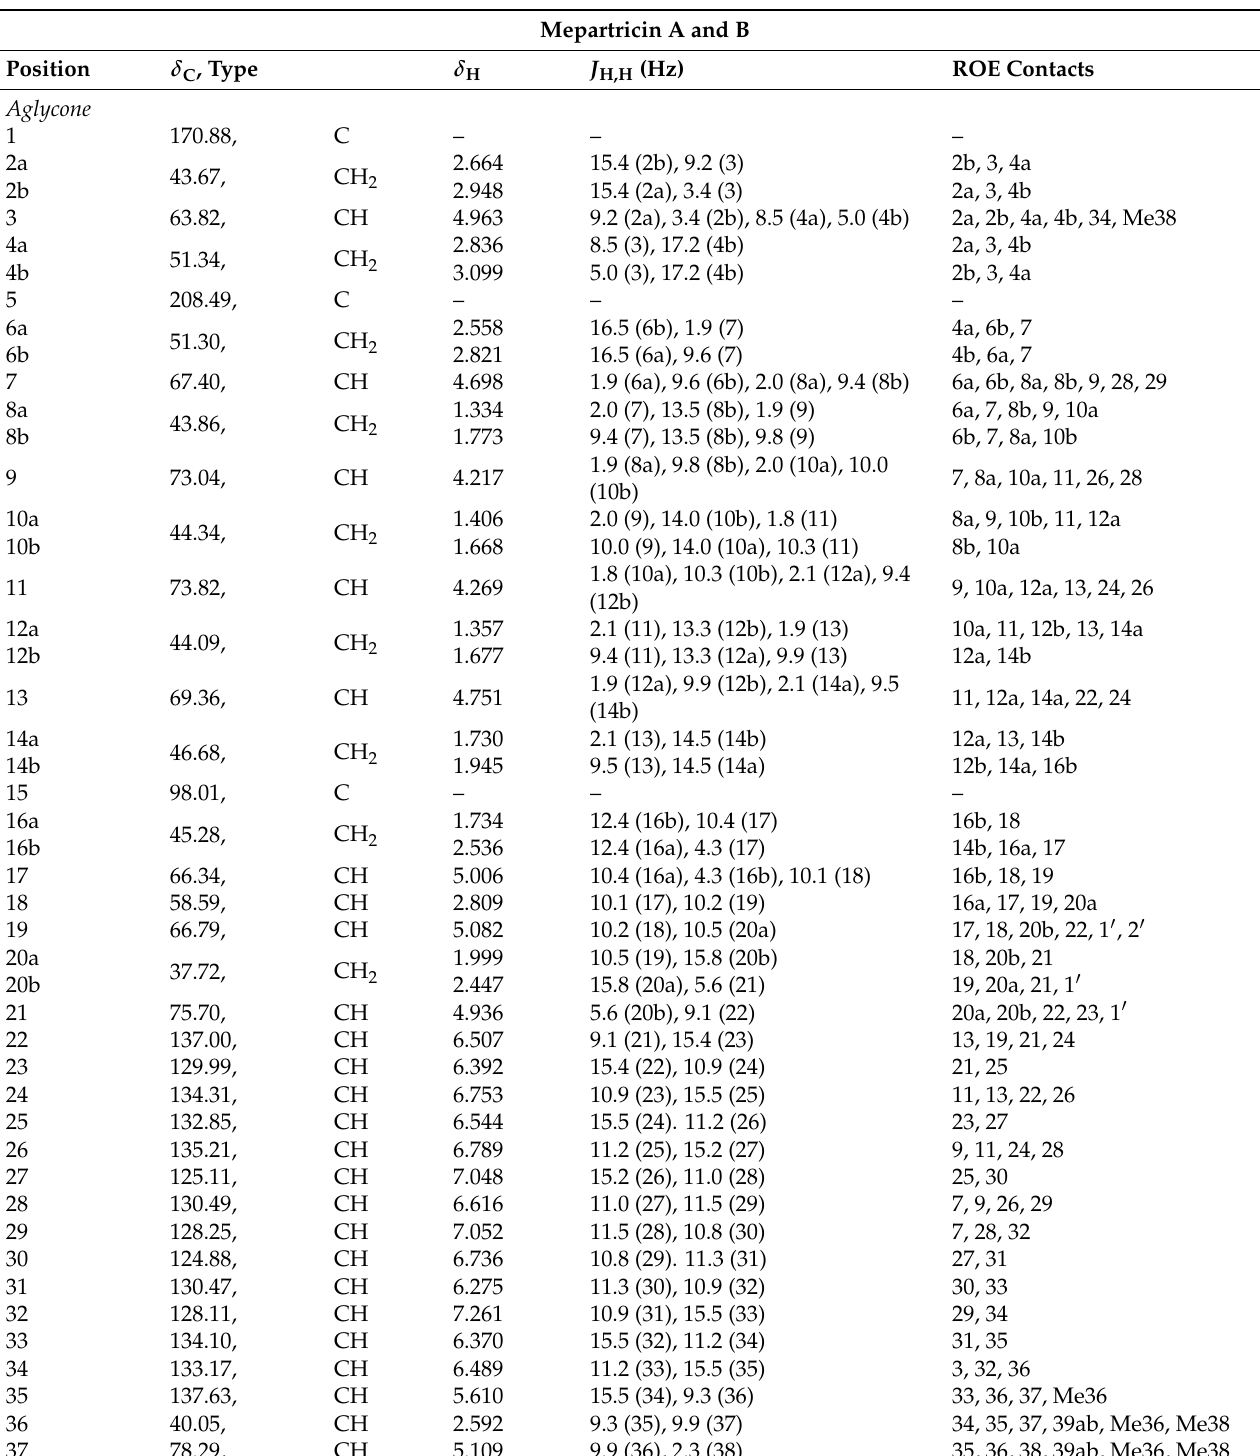
Table A1. 1 H and 13 C-NMR spectroscopic data for mepartricin A and B (700 MHz, C 6 D 5 N/CD 3 OD (9:1, v / v )). In every column, letter A stands for spectroscopic data for mepartricin A, letter B stands for the analogous value for mepartricin B, whereas no letter given means that the presented data is identical for both